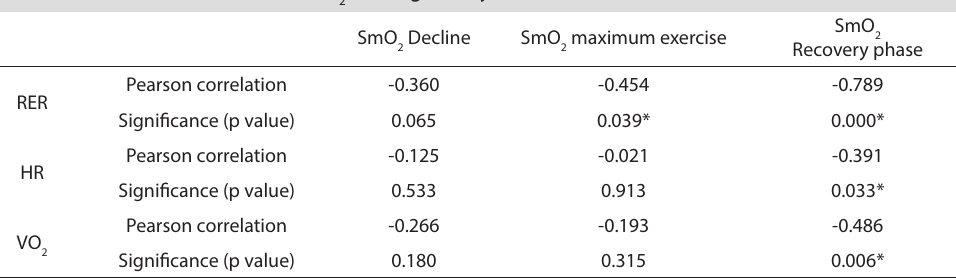
TABLE 3. Correlations between SmO